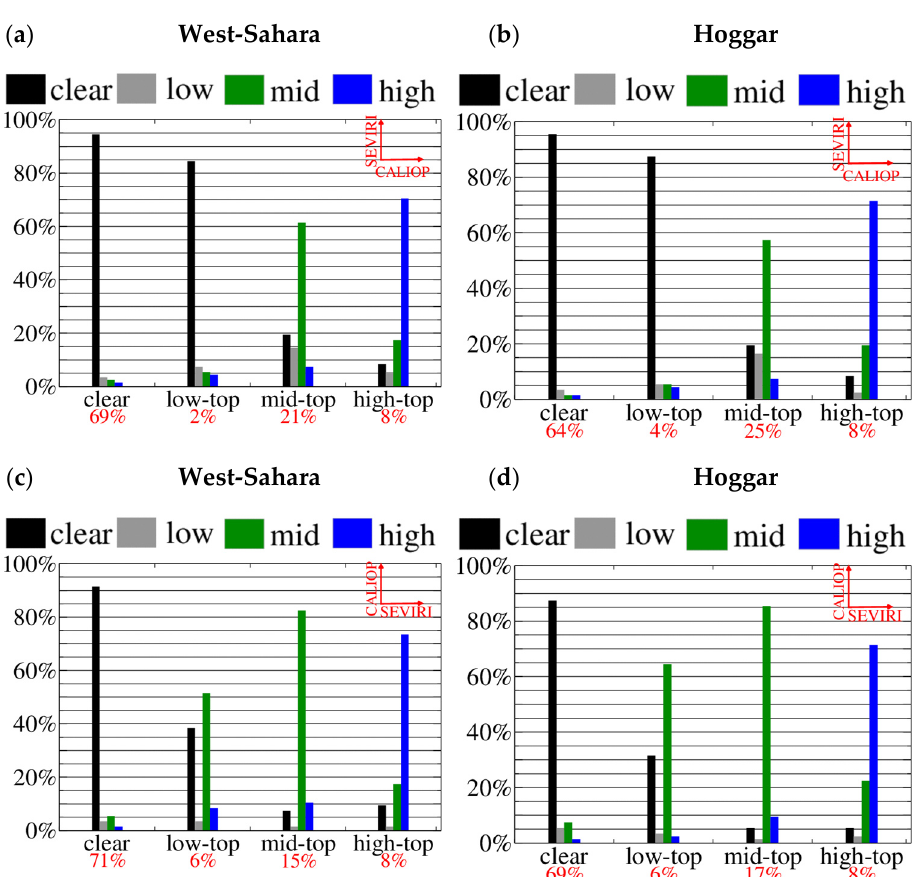
Figure A2. ( a , b ) Occurrence frequency of the SEVIRI cloud class for each CALIOP cloud class and ( c , d ) occurrence frequency of the CALIOP cloud class for each SEVIRI cloud class for ( a , c ) West-Sahara and ( b , d ) Hoggar. The occurrence frequency of each CALIOP ( a , b ) and SEVIRI ( c , d ) class is also given under the class label on the X axis.